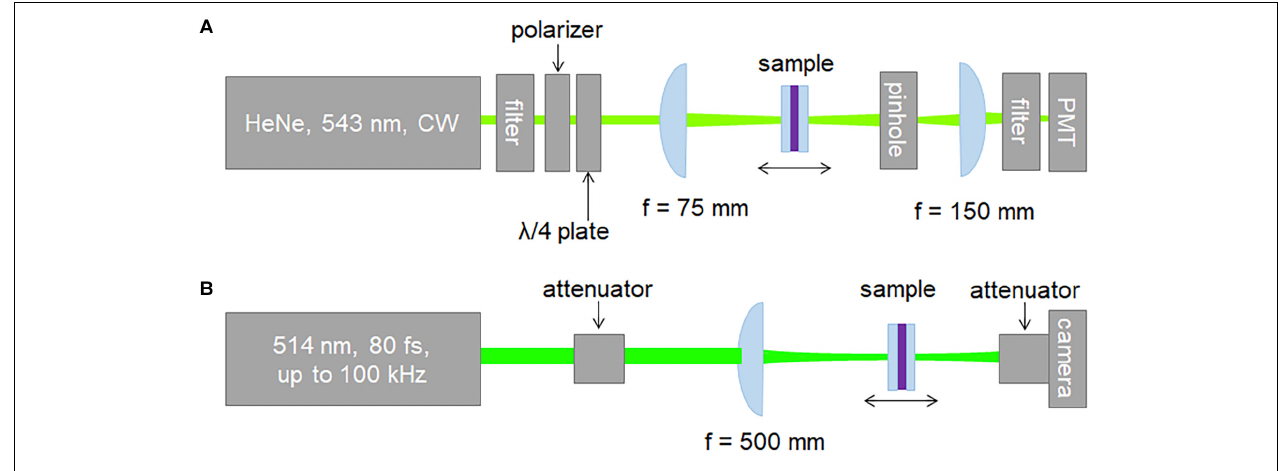
FIGURE 1 | Schematics of the experimental (A) CW and (B) pulsed-mode Z-scan setup.